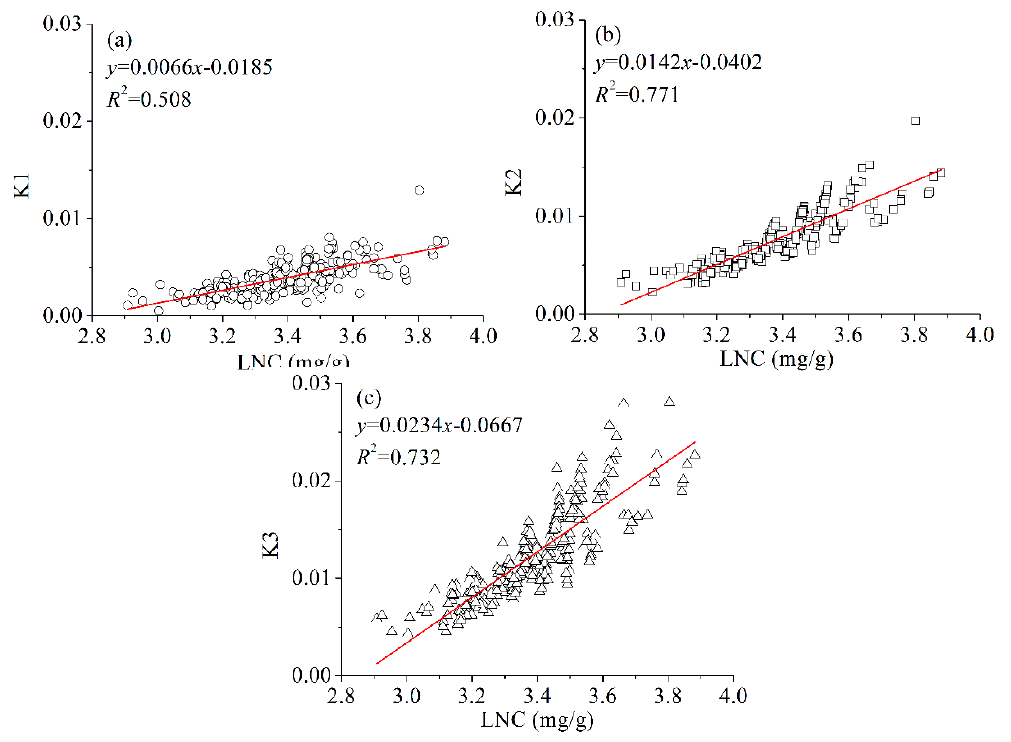
Figure 2. Relationship between the proposed fluorescence characteristics and LNC. The solid line is the linear regression analysis.